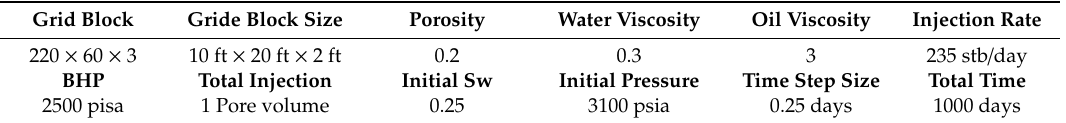
Table 2. Reservoir configuration.